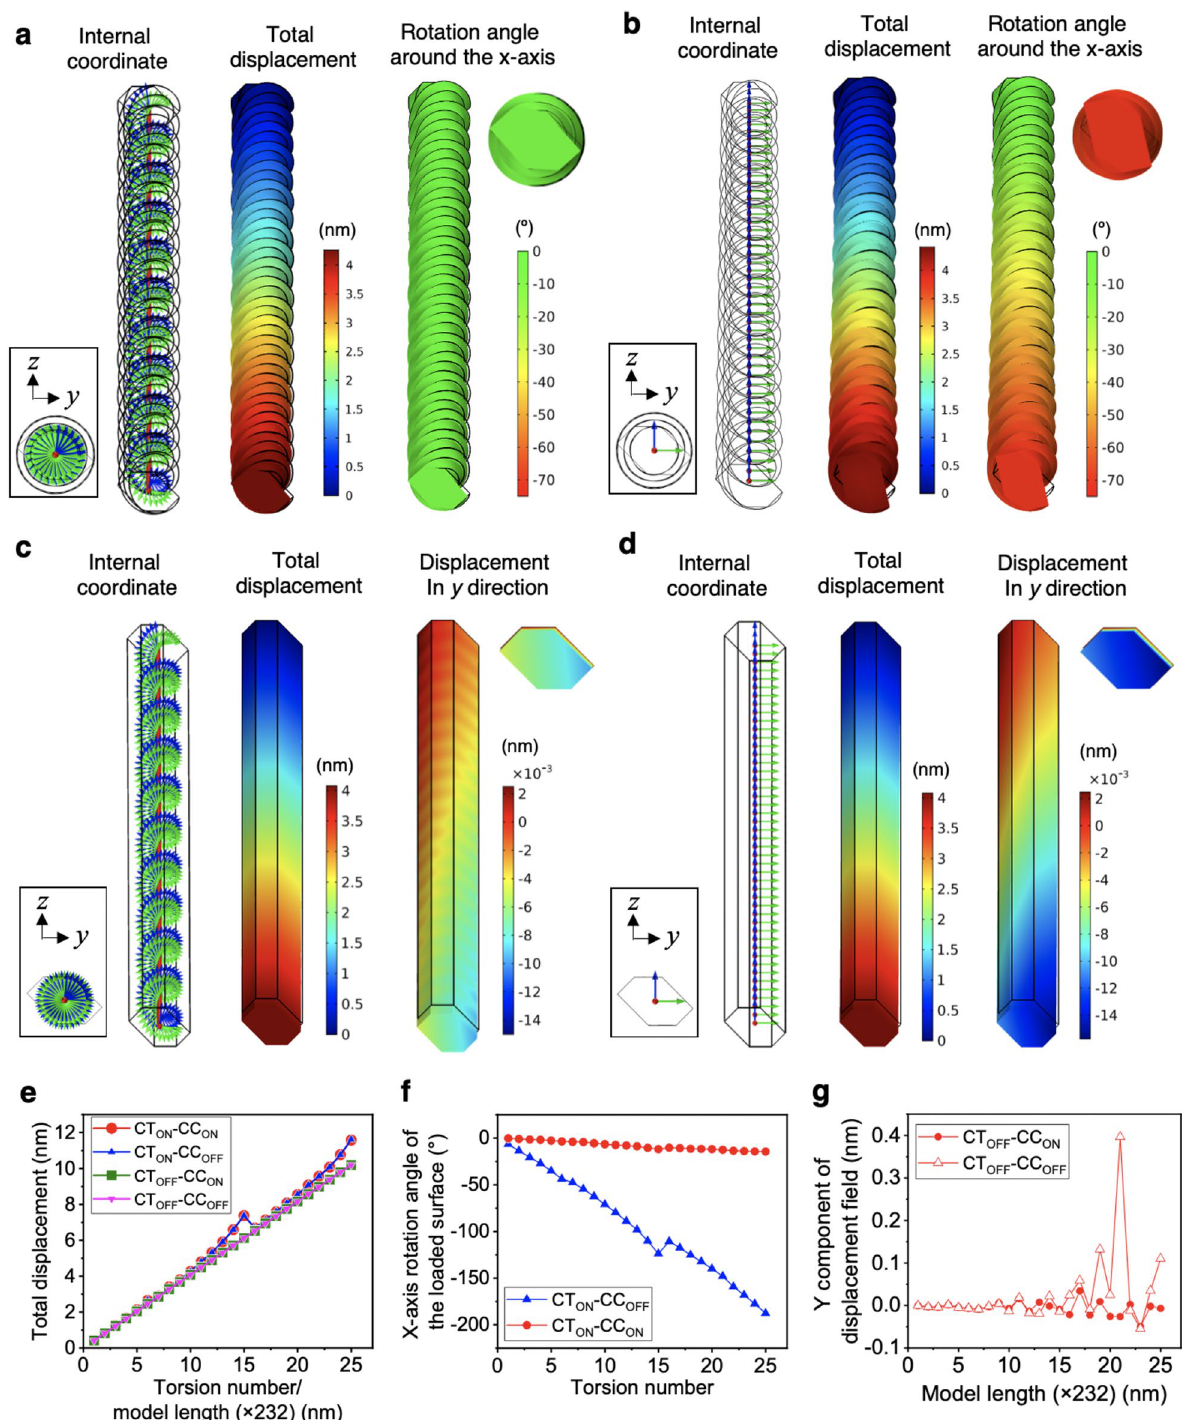
Figure 3. Effects of the contour twist and curvilinear coordinates on tensile deformation. Internal coordinates, total tensile displacement distributions, and the corresponding rotational displacement distributions around the x axis for the typical 10-round twist or equivalent 2320 nm length model with ( a ) contour twist ON and curvilinear coordinate ON (CT ON -CC ON ), ( b ) CT ON -CC OFF , ( c ) CT OFF -CC ON , and ( d ) CT OFF -CC OFF . ( e ) Total displacements for the 1- to 25-round twist models or models of equivalent lengths with four different combinations of contour twisting and curvilinear coordinate. ( f ) Difference in rotational deformation around the x axis between the CT ON -CC ON and CT ON -CC OFF models. ( g ) Difference in deformation along the y axis between the CT OFF -CC ON , and CT OFF -CC OFF models. The simulation model figures were exported by COMSOL Multiphysics 5.4 (https ://www.comso